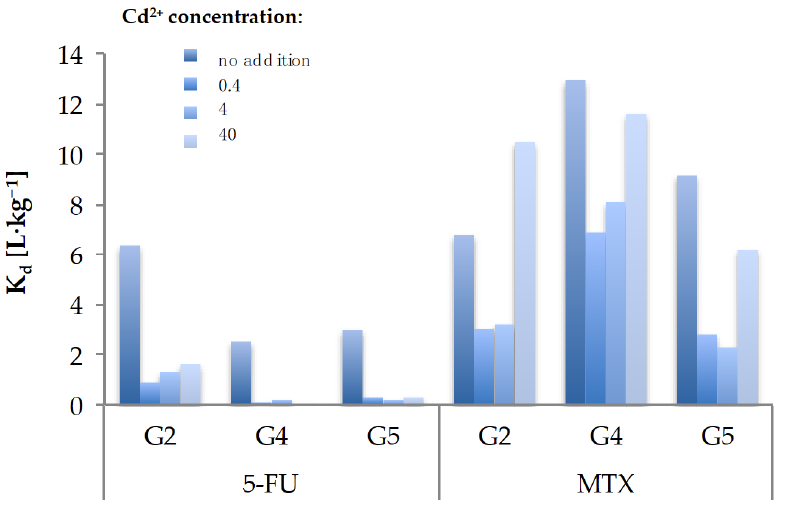
Figure 5. The influence of Cd 2+ presence on the sorption potential of 5-FU and MTX (Basic conditions: medium: 0.01 M CaCl 2 ; concentration levels of cadmium: 0.4, 4.0, 40 mg·kg − 1 d.m.; adsorption equilibrium time: 24 h; optimal S/L ratio: 5-FU (G2 soil = 1:25; G4 and G5 soil = 1:5); MTX (G2, G4, G5 soil = 1:15).